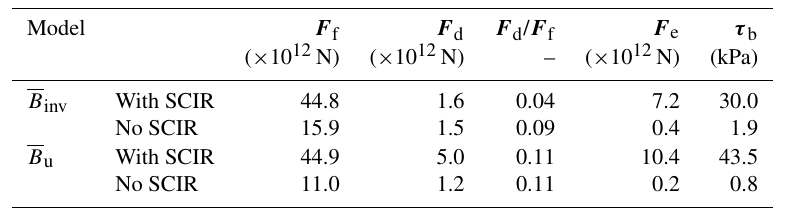
Table 1. Force budget components generated by the SCIR in the reference and perturbed models. Form drag F f is the glaciostatic contribution to the net flow resistance, dynamic drag F d is the viscous resistance associated with ice deformation around an obstacle, and the effective resistance F e is the total reaction force arising from contact between the pinning point and the ice-shelf base. The apparent basal shear stress τ b is the quotient of F e and the total pinning point grounded area (240.4km 2 ). The equations to compute the force budget components are presented in the Supplement, Sect. S3.